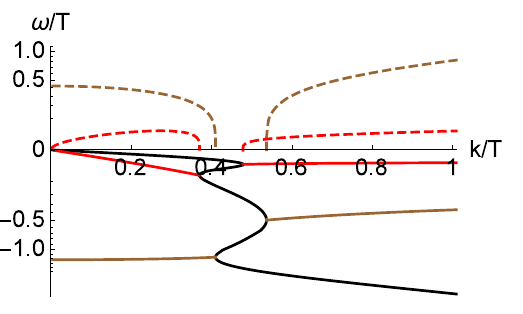
Figure 9 . The lowest CMs at (cid:22)=T (cid:25) 14 : 4, m = 0 : 2 and (cid:12) = 10. Dashed lines are real parts and solid lines are imaginary parts. Sim- ilarly coloured real parts and imaginary parts constitute the same mode. The black line is purely di(cid:11)usive (and technically three di(cid:11)erent modes). The brown line is the imaginary part of the lowest gapped mode, whereof the real part has been omitted, as it is an order of mag- nitude beyond the scale of the other